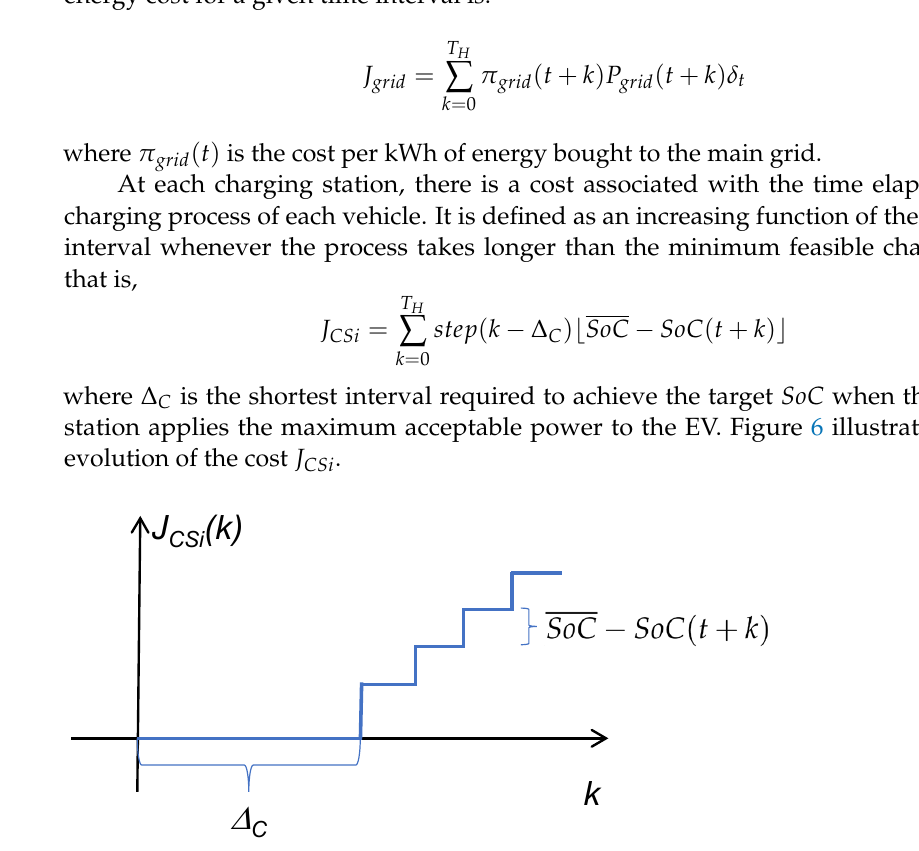
Figure 6. Time evolution of the cost associated with the delayed charging